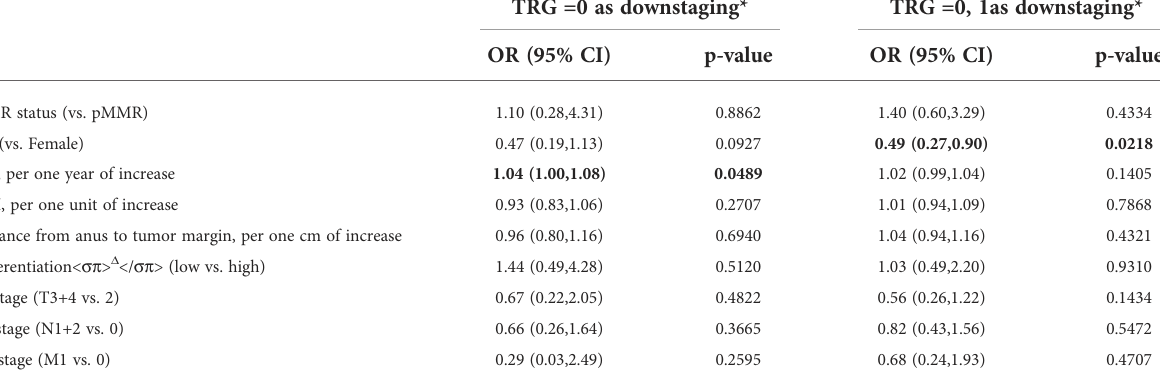
TABLE 3 Characteristics at baseline associatedwith downstaging (TRG=0 or TRG=0 or 1) among the 269 MMR patients according to multiple logistic regression.